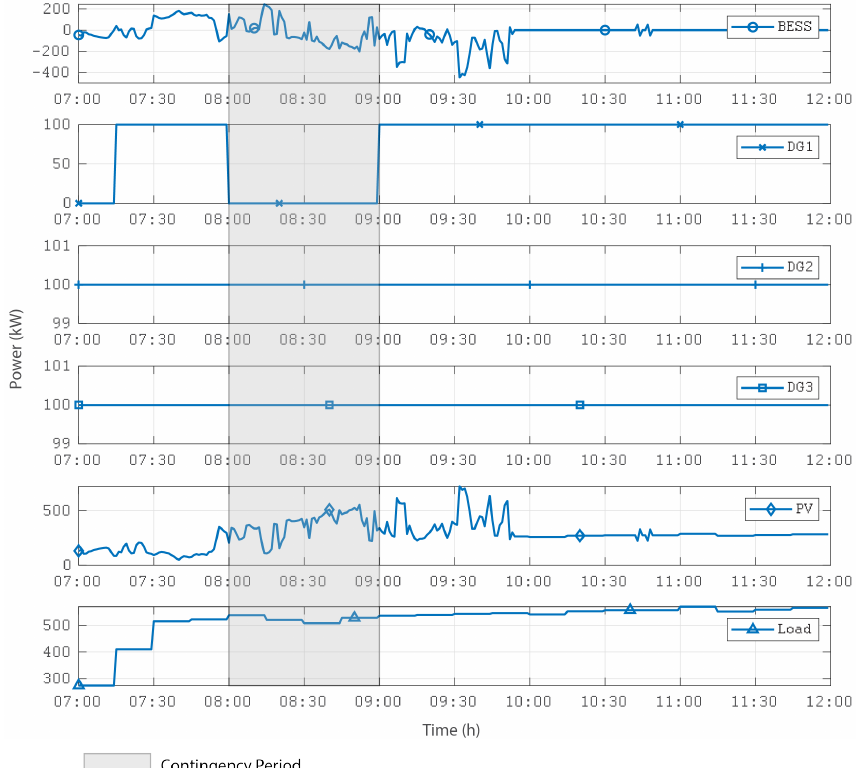
Figure 11. DERs generation and ASC load curves for off-grid operation—case with a single DG unit outage.